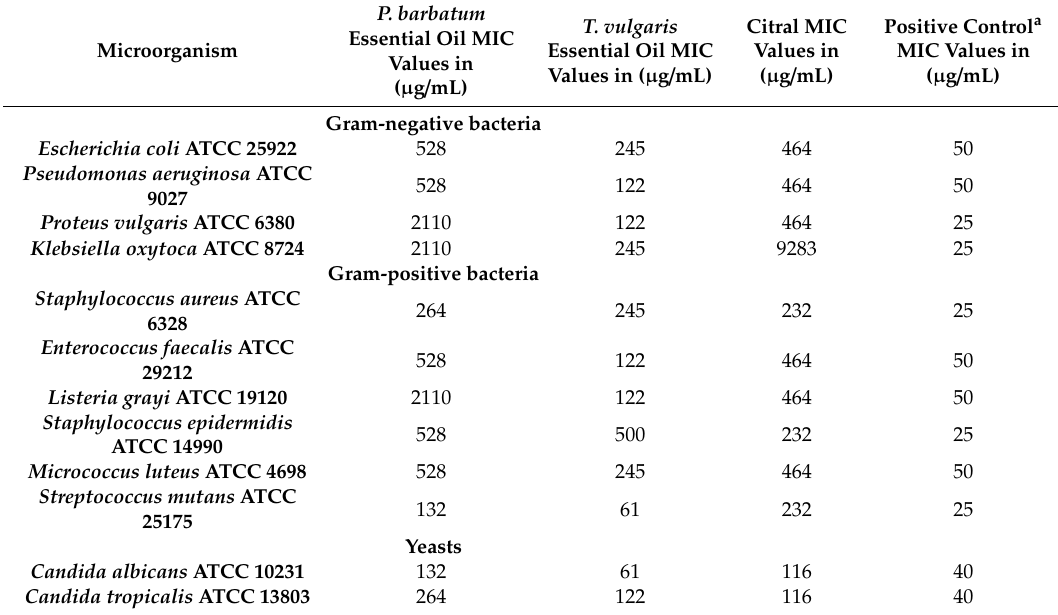
Table 2. Values of the minimum inhibitory concentration of P. barbatum essential oil in the di ff erent